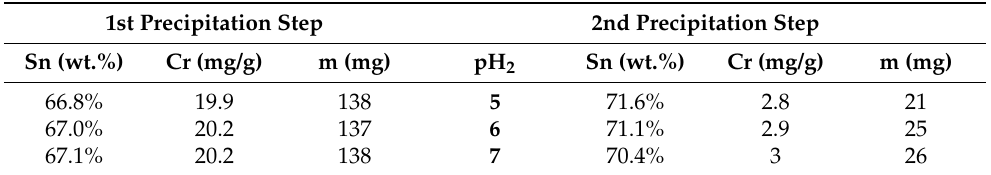
Table 9. Sn and Cr concentration in solids produced at reconstruction process in relation to the